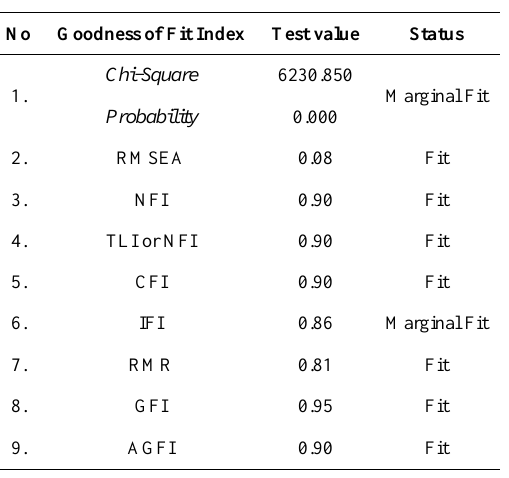
Table 6. Full Model_1 Test Results